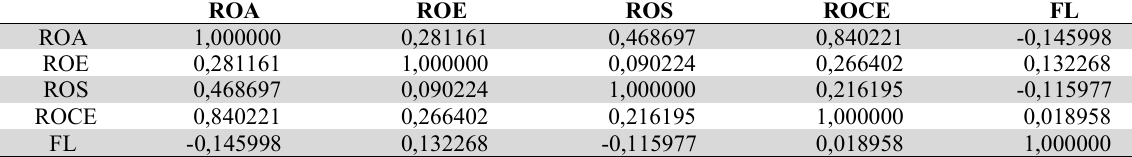
The correlation between independent and dependent variances